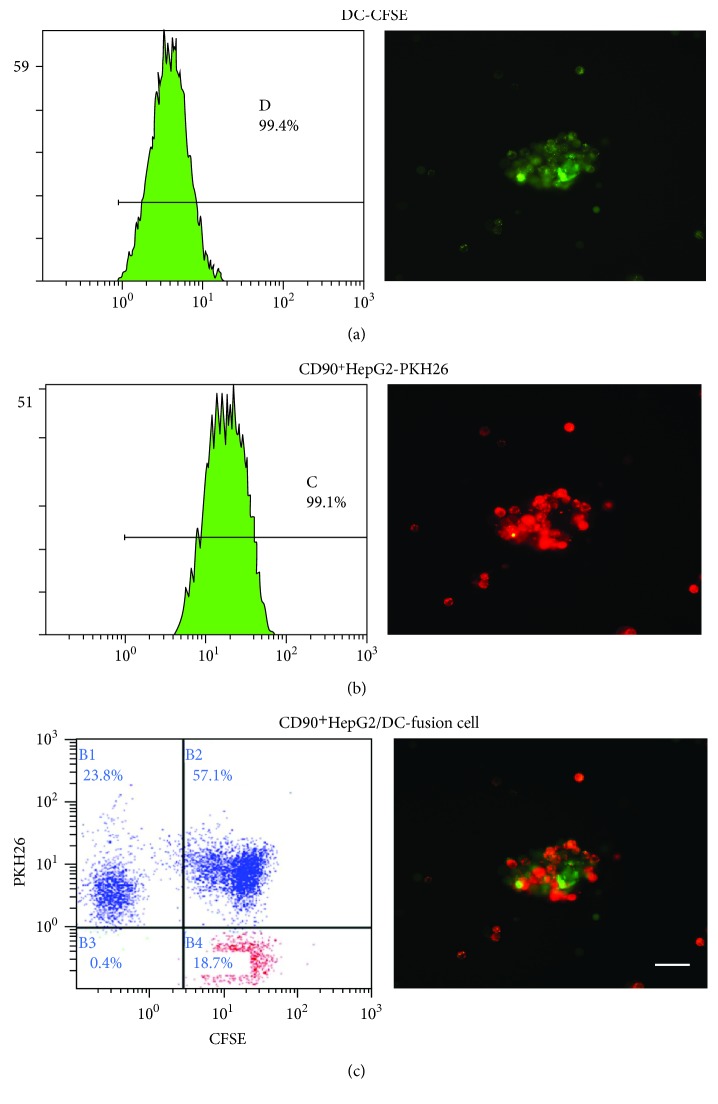
The immunofluorescent staining of DC and CD90+HepG2 and the fusion rate estimated by FCM. The fusion rate was estimated by immunofluorescence and FCM. (a) Dendritic cell (green), ×100, FCM analysis shows that the CFSE-positive rate is 99.4%. (b) CD90+HepG2 (red), ×100, FCM analysis shows that the PKH26-positive rate is 99.1%. (c) Fusion cells (green and red), ×100, FCM analysis shows that the double-positive rate is 57.1%.